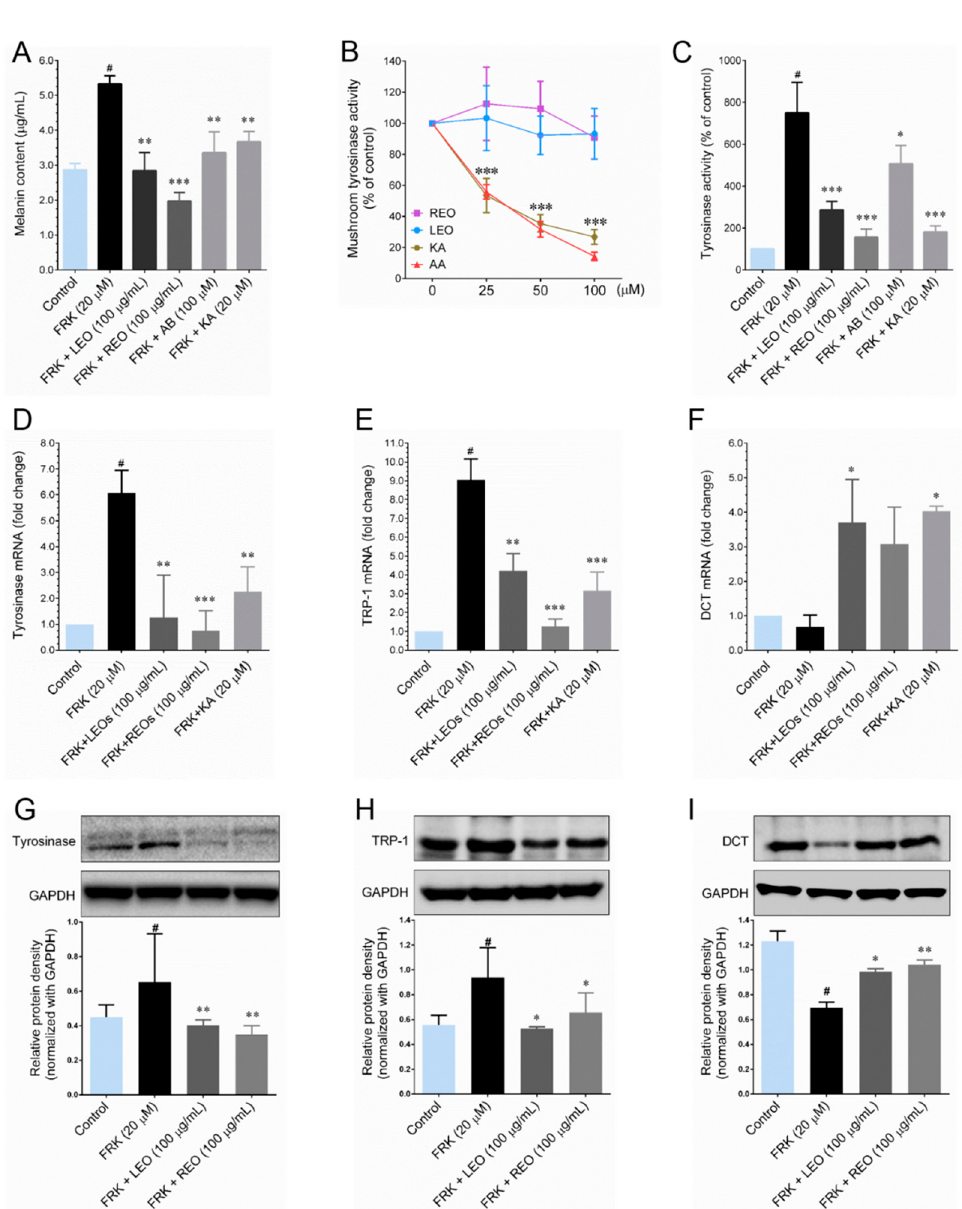
Figure 1. Inhibitory e ff ect of leaf (LEO) and rhizome (REO) essential oils on melanin content and tyrosinase enzyme activity in forskolin (FRK)-induced B16-F10 melanoma cells. ( A ) Cells were treated with indicated concentrations of LEO, REO, arbutin (AB) and kojic acid (KA) and stimulated with FRK for 48 h. Melanin content was assessed by with an absorbance at 405 nm. Cellular melanin content was calculated by comparison with a melanin standard curve. ( B ) The relative activity of mushroom tyrosinase on L-DOPA in the presence of increasing concentrations of LEO, REO, KA and ascorbic acid (AA), compared to the control (100%). ( C ) E ff ect of cellular tyrosinase activity was determined using whole cell lysates. After treatment with indicated concentration of LEO, REO, AB and KA for 48 h. Cell lysates were used as enzyme source and L-DOPA as substrate. The e ff ects on L-DOPA oxidation velocity was measured at 492 nm. ( D – F ) Relative mRNA expression levels of tyrosinase, TRP-1 and dopachrome tautomerase (DCT) were determined by Q-PCR analysis. ( G – I ) Protein expression levels of tyrosinase, TRP-1 and DCT were determined by Western blot analysis and the histogram showed relative protein expression, which were normalized with loading control GAPDH. Data represent the mean ± SD of three experiments. Statistical significance was set at # p < 0.05 compared to control vs. FRK and * p < 0.05, ** p < 0.01, *** p < 0.001 compared with FRK + sample treatment groups vs. control